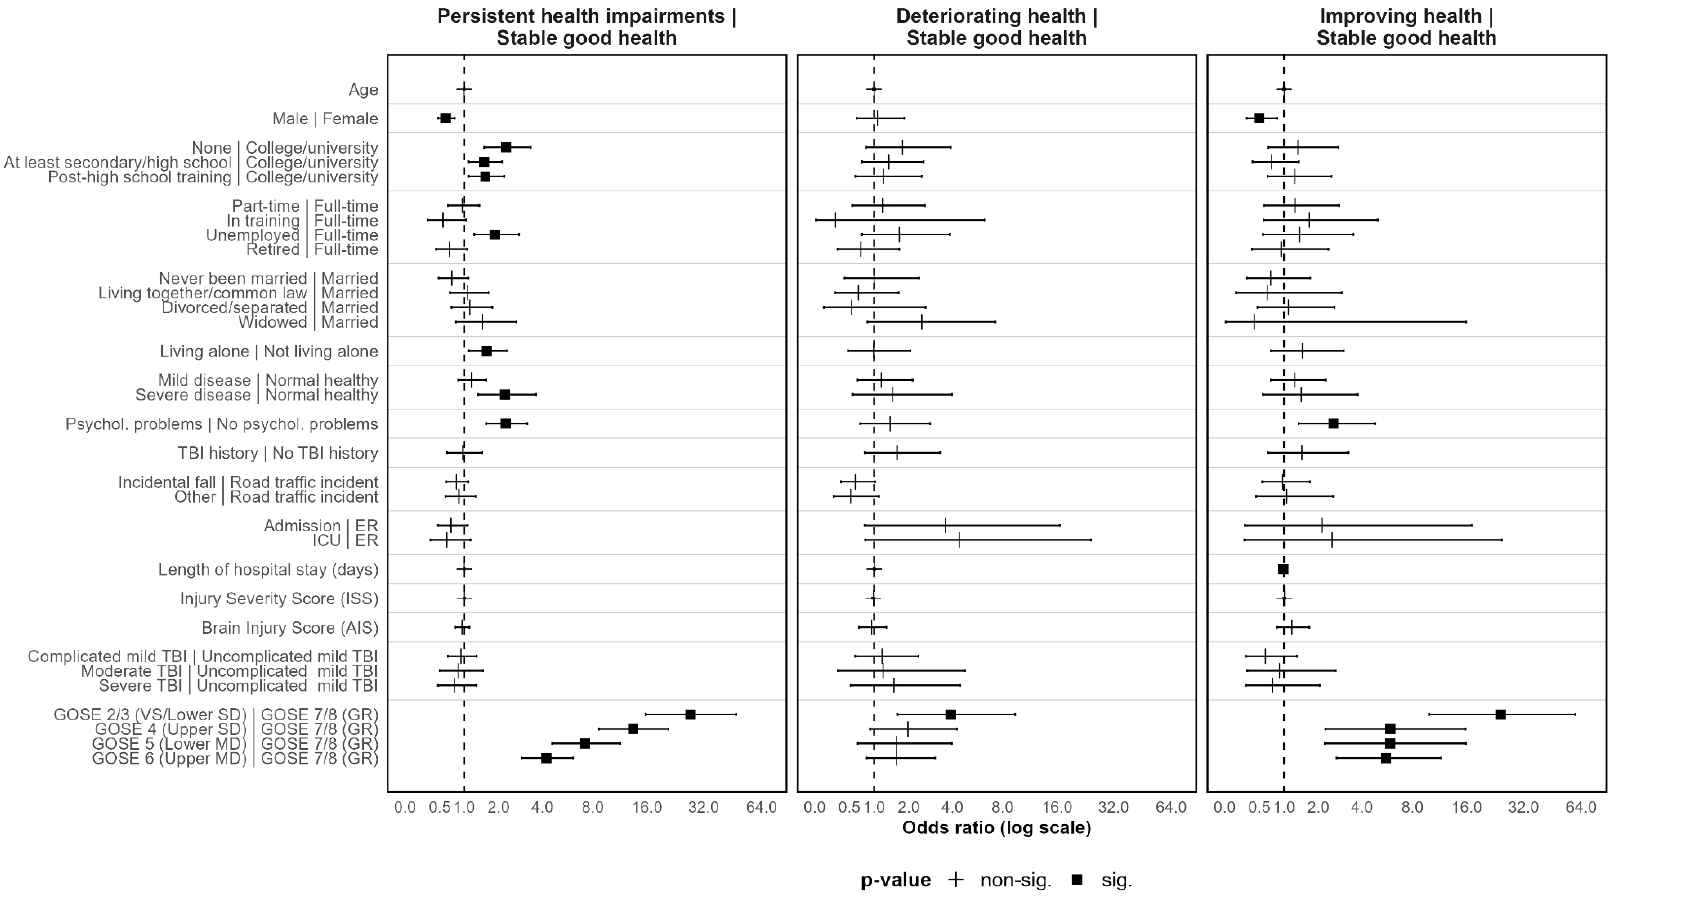
Figure 6. HRQoL trajectories (QOLIBRI-OS, SF-12 MCS, SF-12 PCS) for the four-class solution of model 1 (random intercept, fixed slope). Stable good health status class is used as the reference group. Odds ratios and 95%-confidence intervals depicted. Reference group for each categorical variable listed after vertical line. SD = severe disability, MD = moderate disability, GR = good recovery. Values below 1 indicate lower probability of belonging to the non-reference group (i.e., persistent health impairment, deteriorating health, or improving health) compared to the stable good health group.